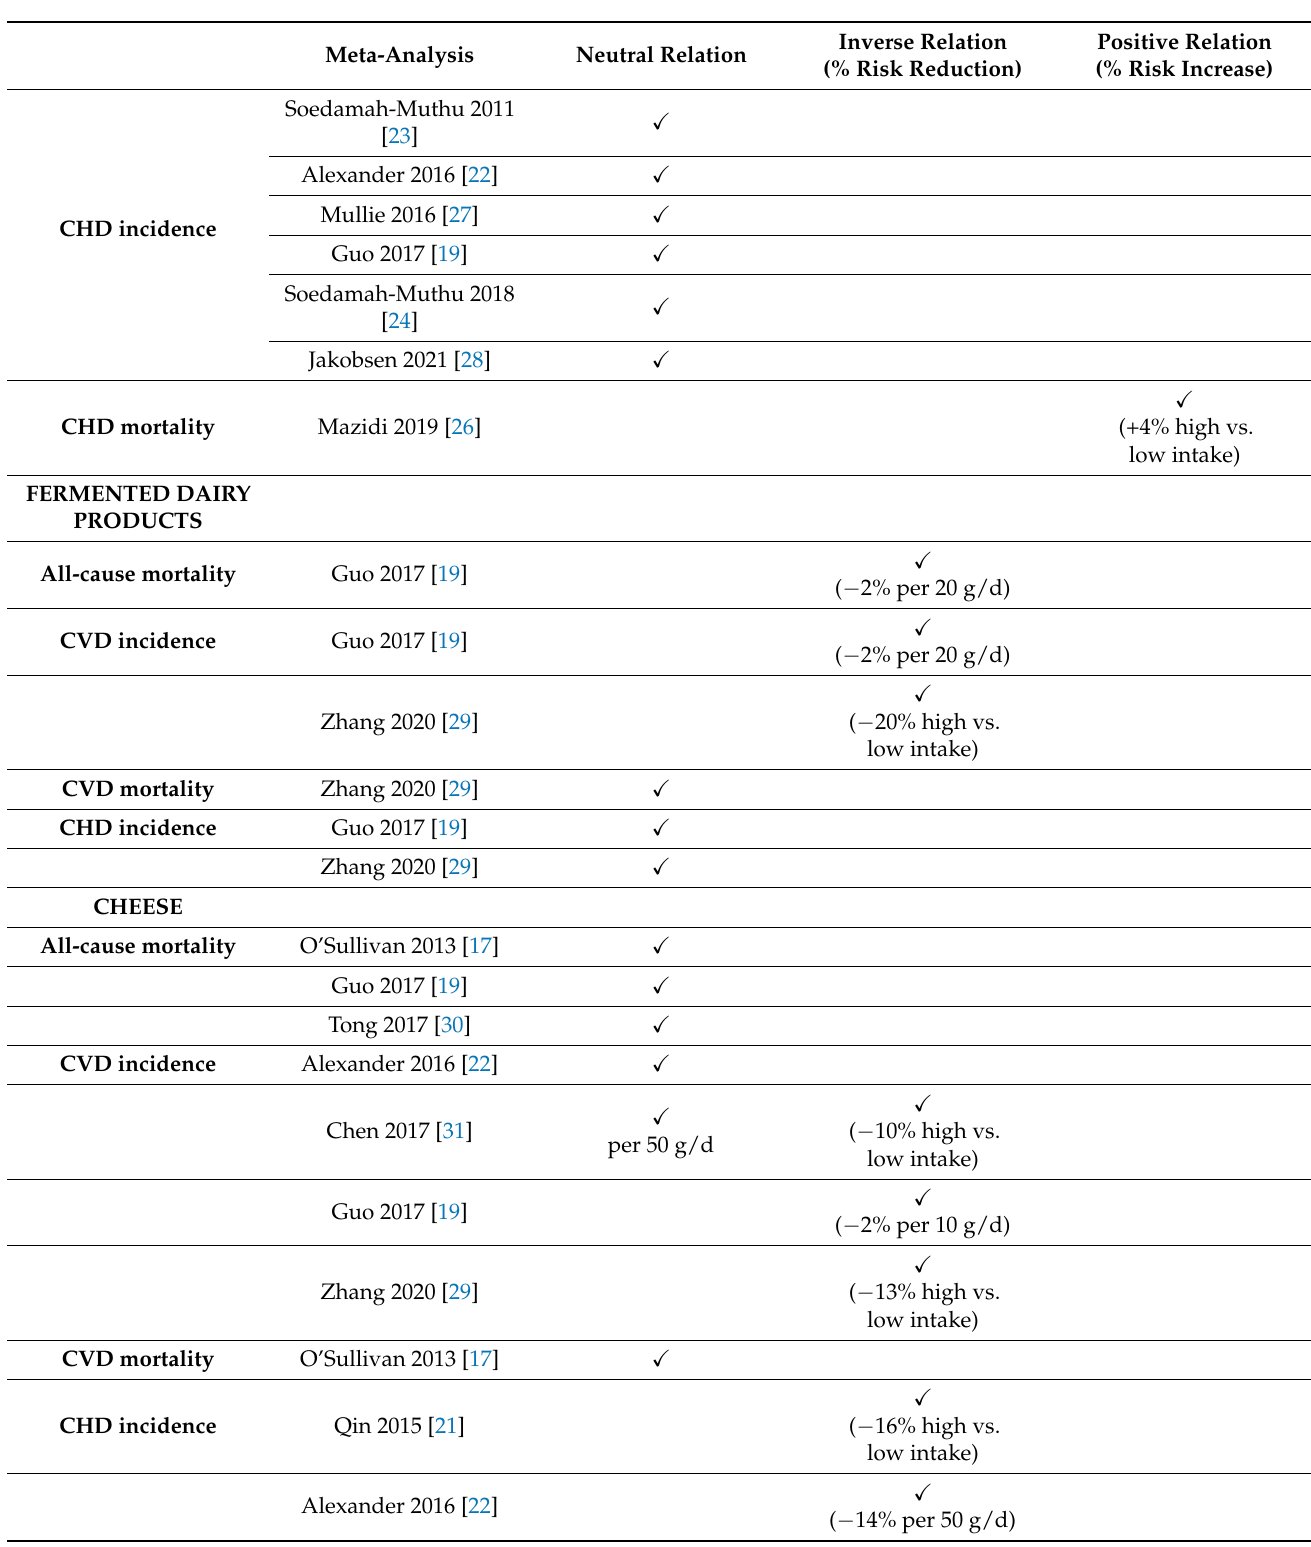
Table 1. Cont. Meta-Analysis Neutral